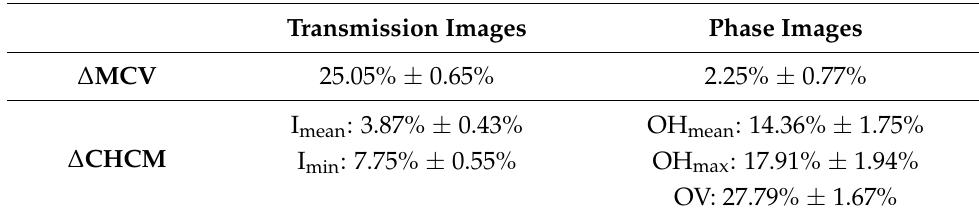
Table 1. Deviations of MCV and CHCM values obtained by our measurements and by the reference system Siemens ADVIA